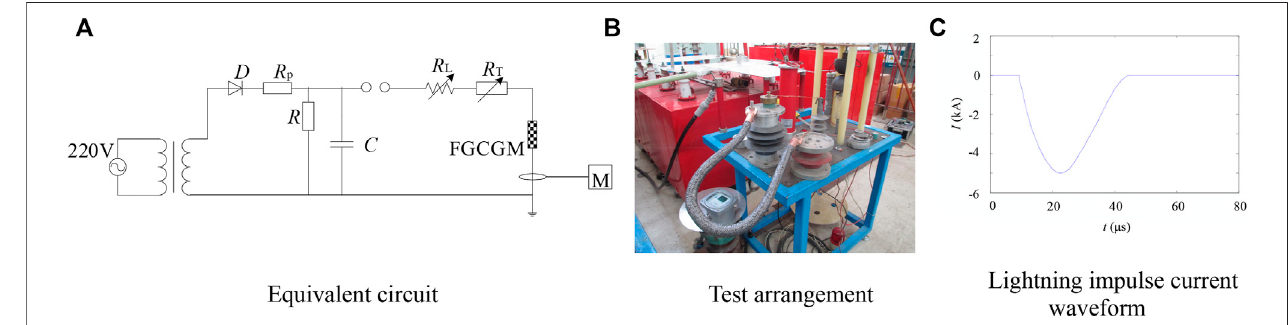
FIGURE 6 | Test arrangement with lightning impulse currents.